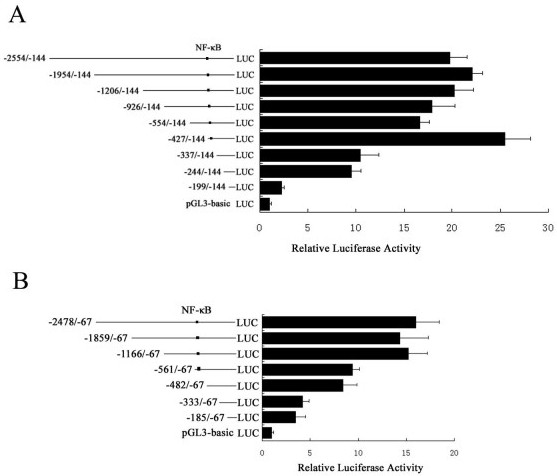
Reporter analysis of the mouse CS1 and CS2 gene promoters. A. Reporter analysis of mouse CS1 gene promoter deletion constructs. B. Reporter analysis of mouse CS2 gene promoter deletion constructs. The 5'-deleted promoter segments were generated as described in Materials and Methods. C2C12 cells were co-transfected with various promoter regions fused to firefly luciferase and with a Renilla luciferase expression control vector. The resulting firefly luciferase activity was then normalized to Renilla luciferase activity and the relative values are presented as the fold-increase over the activity of the promoterless pGL3-basic vector. The length of each 5'-deletion fragment is calculated relative to the translation initiation ATG codon and is indicated to the left of each bar. The presence of putative NF-κB binding elements is also indicated. Values represent the mean ± SD of three independent experiments.